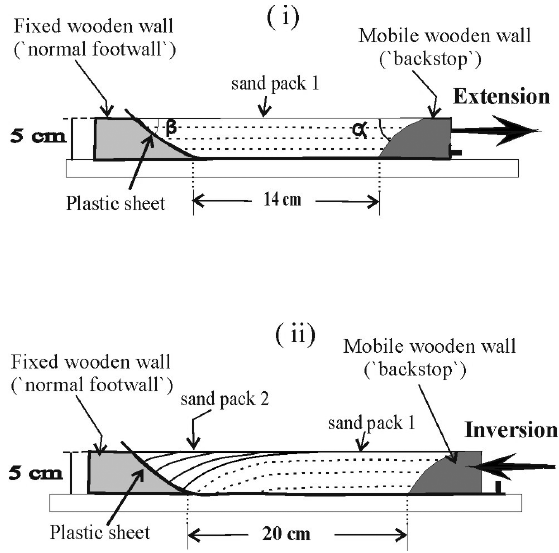
Fig. 2 – Schematic illustrations of the experimental apparatus for se- quence 1 (in sequences 2 and 3 the backstop is concave-up and vertical, respectively). (i) Apparatus before extension, and (ii) apparatus after extension and before inversion. Sand pack 1 represents the rift infill during the oldest extension event (also named syn-rift 1) (not simu- lated), and sand pack 2 represents the syn-rift deposit of the second extension event (also named syn-rift 2) – our first deformation step. α and β are the backstop and the normal footwall cut-off angles, respec-